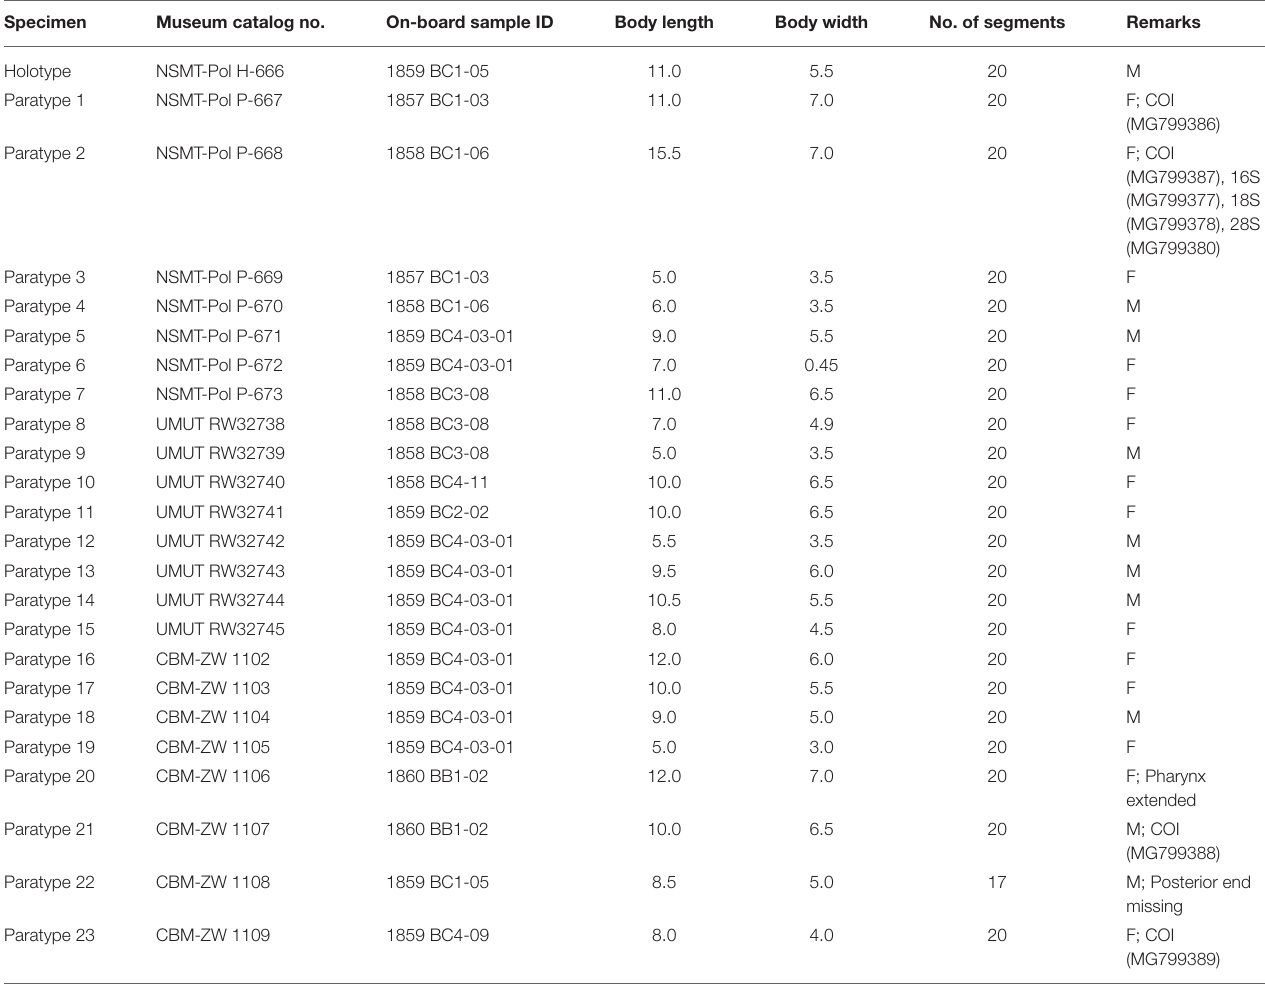
TABLE 2 | General information of specimens of Branchinotogluma elytropapillata sp. nov. used in this study.